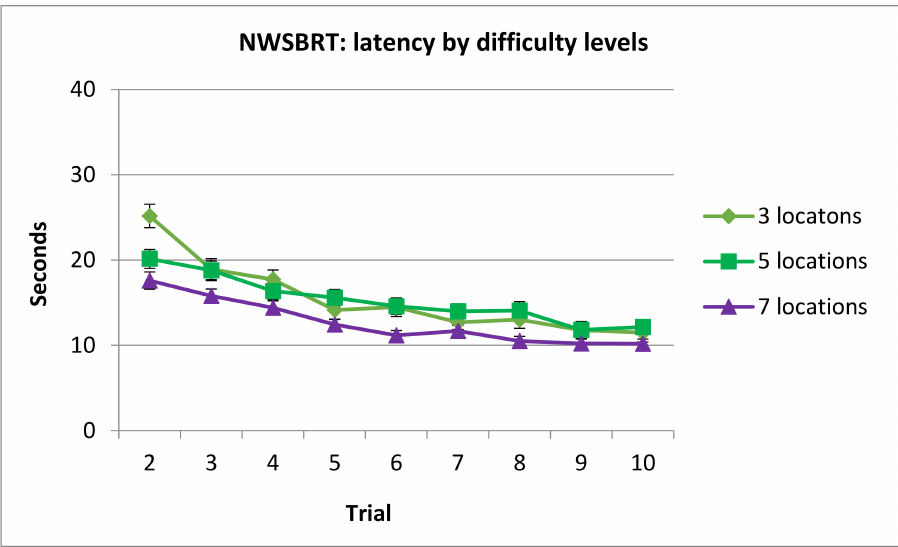
Figure 9. Time spent in NSBRT by trials and difficulty levels. Note that trial 1 was removed from analysis since performance was at random. (Mean ±